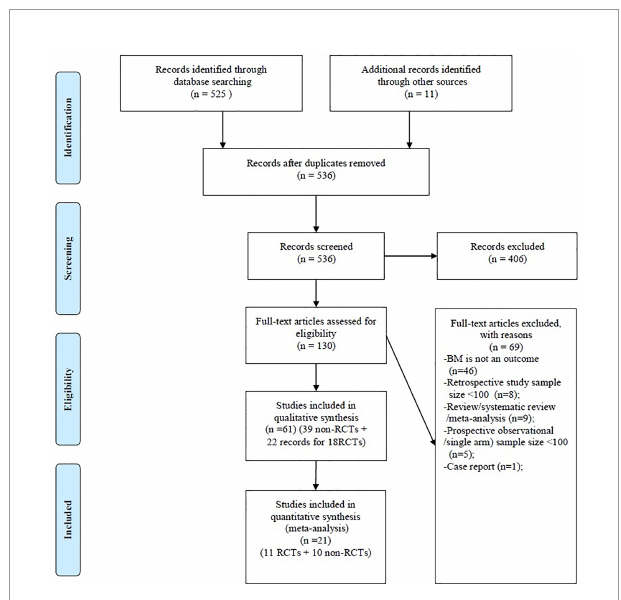
FIGURE 1 | PRISMA fl ow diagram. BM, brain metastasis; Non-RCTs, non- randomized clinical trials; RCTs, Randomized clinical